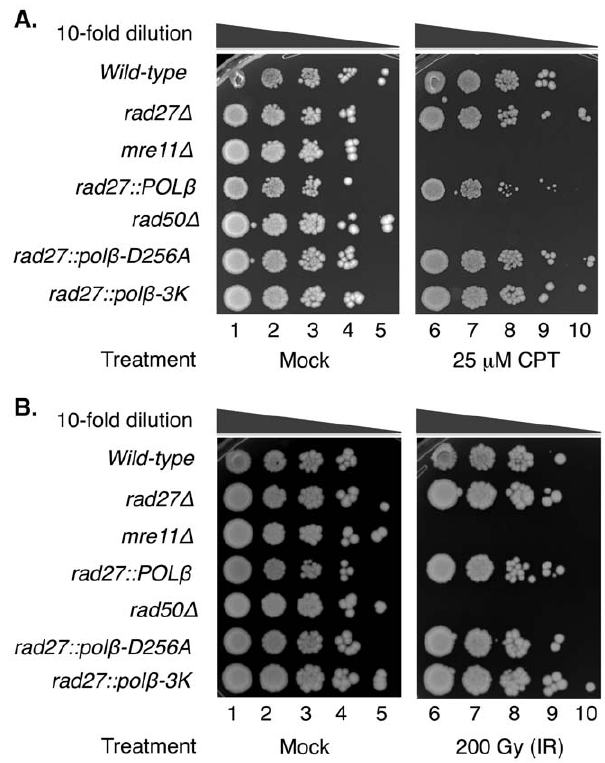
Figure 7. Rescue of CPT and ionizing radiation sensitivity by human Pol b dRP lyase. (A) Ten-fold dilutions of each indicated strain were spotted onto plates containing either DMSO alone (mock, lanes 1– 5) or 25 m M CPT (lanes 6–10). POL b strains were not sensitive to CPT, an agent that produced 3 9 blocking groups. mre11 D and rad50 D deleted strains were used as positive controls for CPT-sensitivity. (B) POL b strains do not display sensitivity to ionizing radiation (IR), an agent that produces predominately 3 9 blocking groups. As in (A), mre11 D and rad50 D deleted strains were used as positive controls for IR sensitivity. Indicated strains were plated and treated as described in Material and Methods, and were mock-treated (lanes 1–5) or subjected to 200 Gray (Gy) of IR, lanes